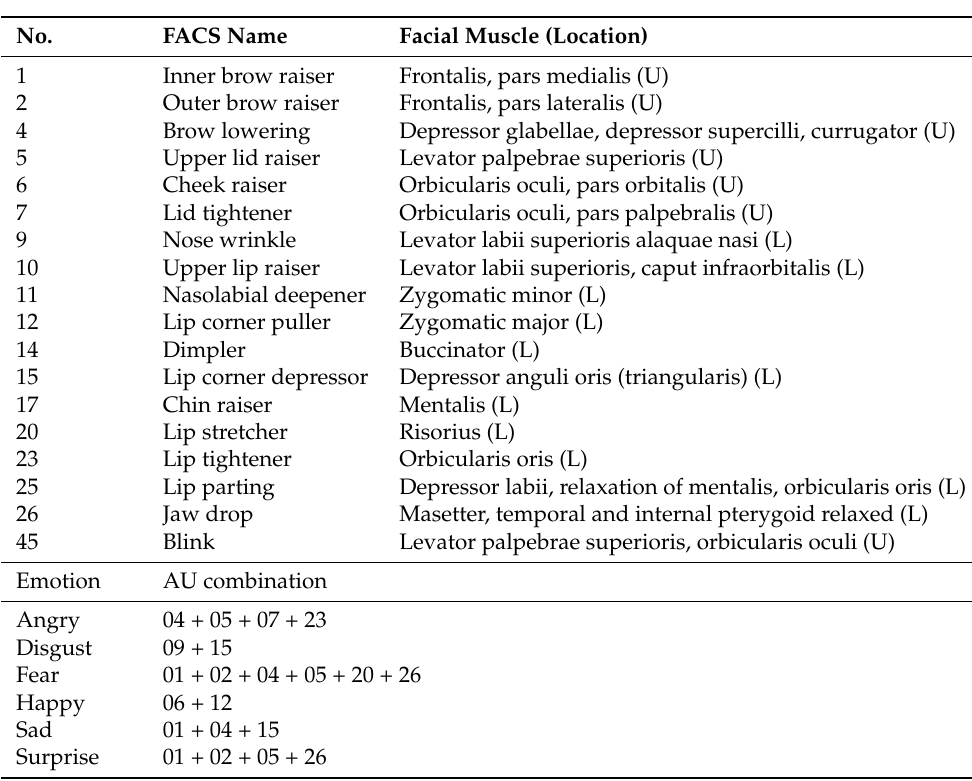
Table 2. Action unit descriptions and combination of each